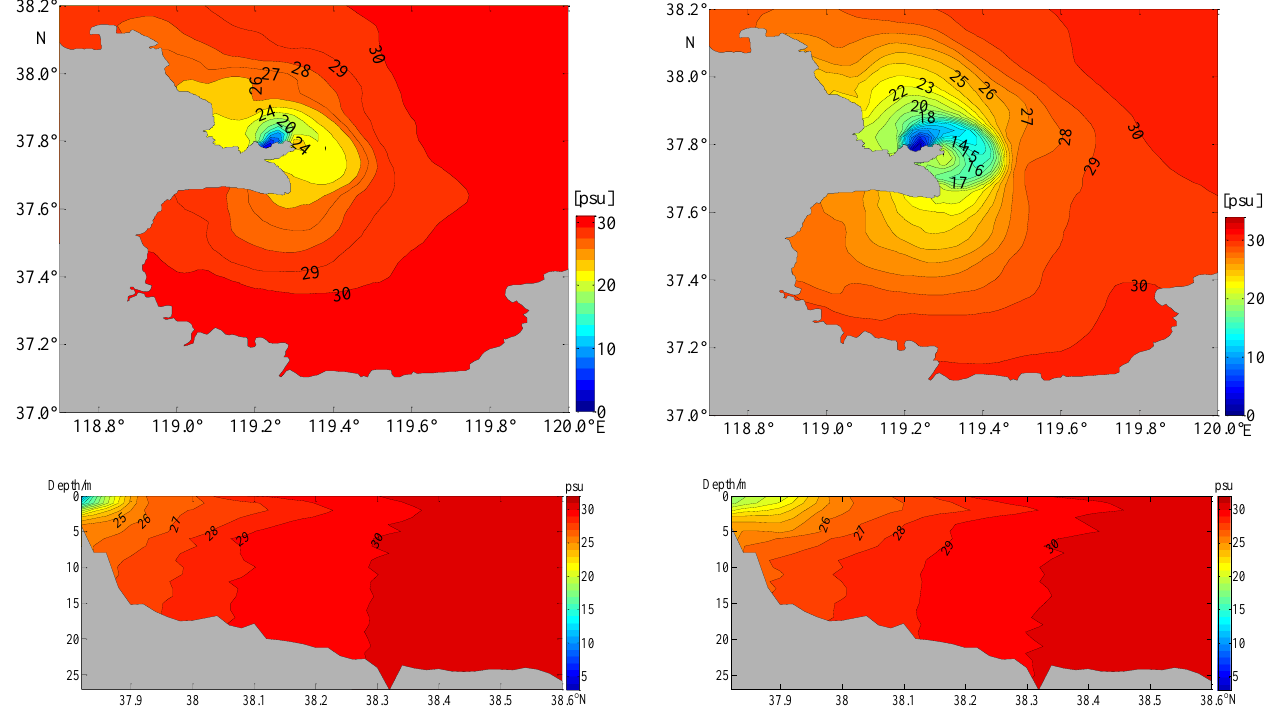
Figure 12. Surface ( top ) and vertical ( bottom ) salinity distribution of case 1 ( left ) and case 2 ( right ).